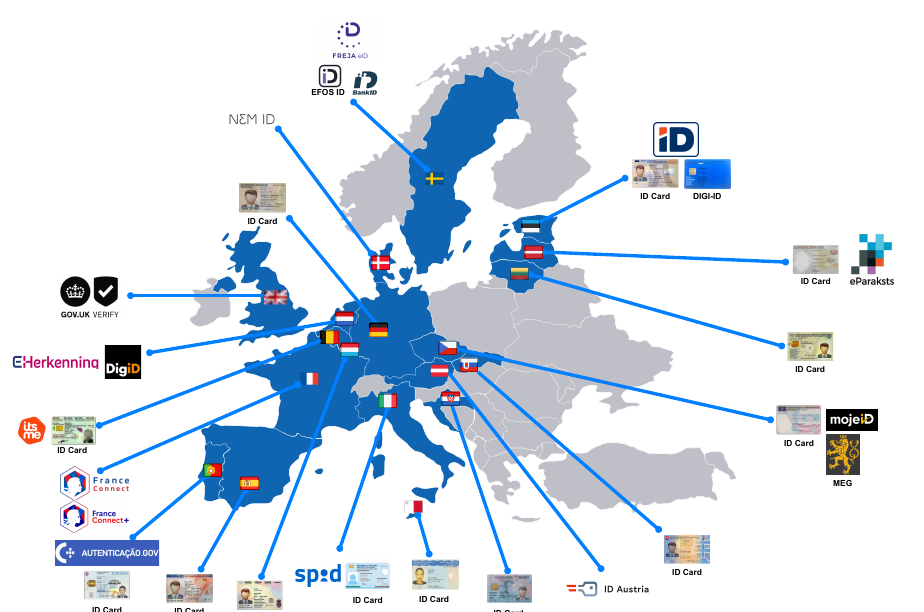
Figure 2. eIDAS notified eID schemes (24 notified eID schemes with 40 eID